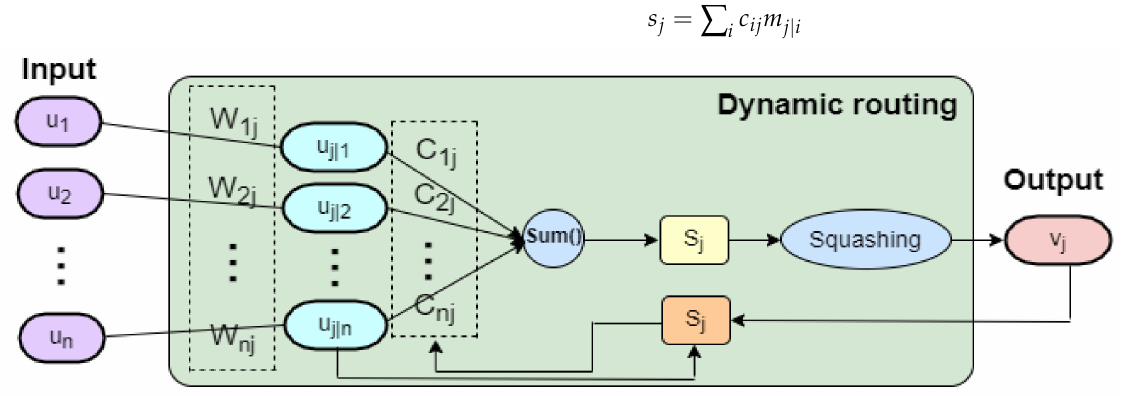
Figure 3. The dynamic routing algorithm in